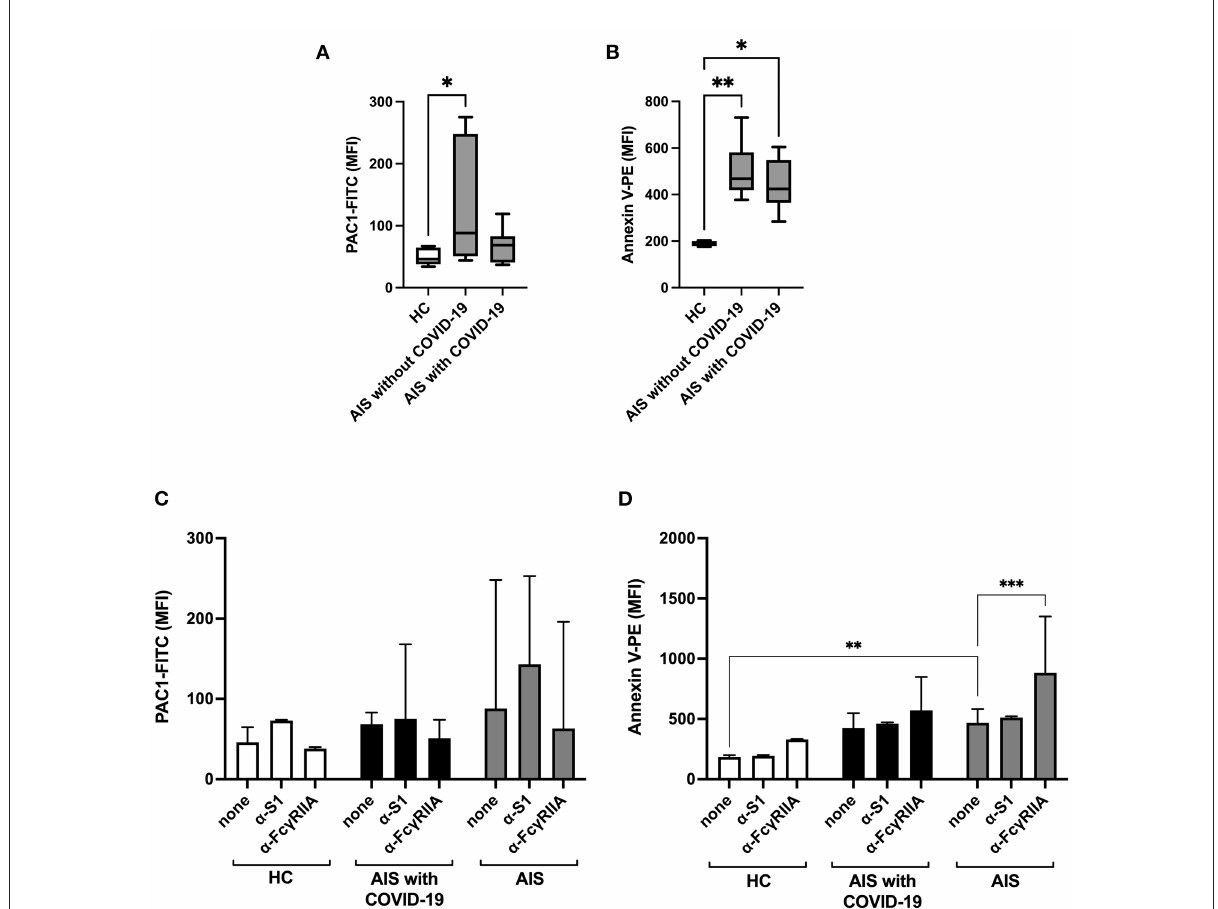
FIGURE2 Sera from AIS patients, with or without COVID-19, induce activation of platelets from healthy controls. Flow cytometric analysis of (A, C) integrin activation (shown as median fluorescence intensity, MFI, of PAC1-FITC) and of (B, D) phosphatidylserine exposure, i.e., platelet pro-coagulant activity (shown as MFI of Annexin V-PE) of washed healthy platelets (of n = 3 healthy donors combined) incubated with sera from acute ischemic stroke (AIS, n = 10) patients, with or without COVID-19, or of healthy controls (HC, n = 6), in the presence or absence of blocking antibodies for the spike protein subunit 1 protein ( α -S1) or the Fc γ RIIA ( α -Fc γ RIIA) [Kruskal Wallis test for (A, B) ; two-way ANOVA for (C, D) ]. * p < 0.05, ** p < 0.01, *** p < 0.001.